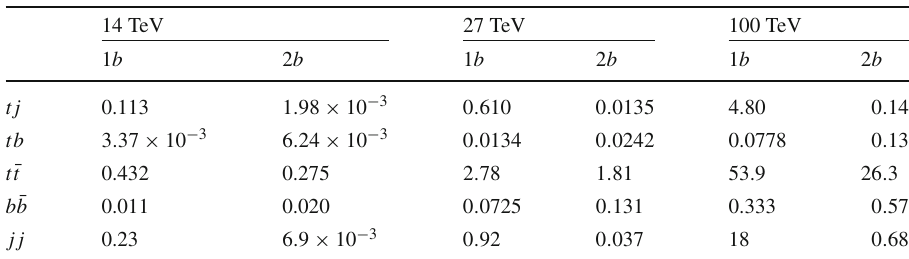
Table 4 Cross sections (in fb) for the different processes in the 1 b and 2 b samples with the final selection, for z 1 ≥ 0 .